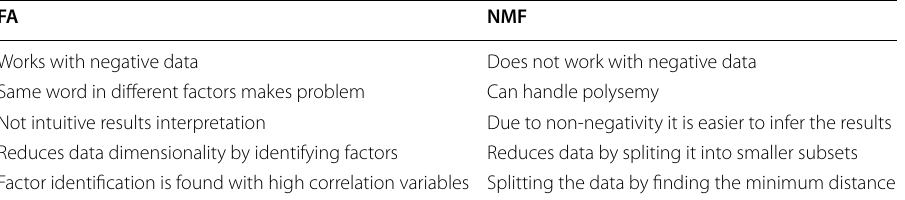
Table 2 Difference between FA and NMF FA NMF Works with negative data Does not work with negative data Same word in different factors makes problem Can handle polysemy Not intuitive results